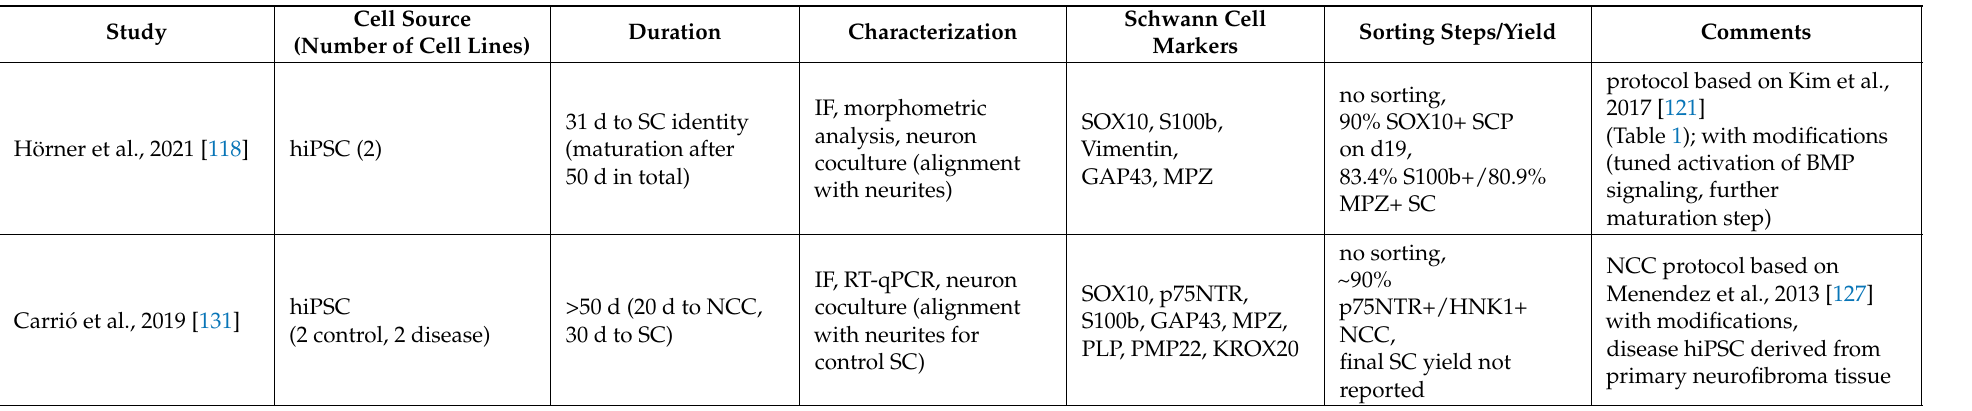
Table 2. Studies demonstrating differentiation of Schwann cells from hiPSC and/or hESC, which were based on primary protocols and contributed important modifications . Also including some neural crest protocols with first demonstrations of Schwann cell lineage differentiation capacity. Sorted from most to least